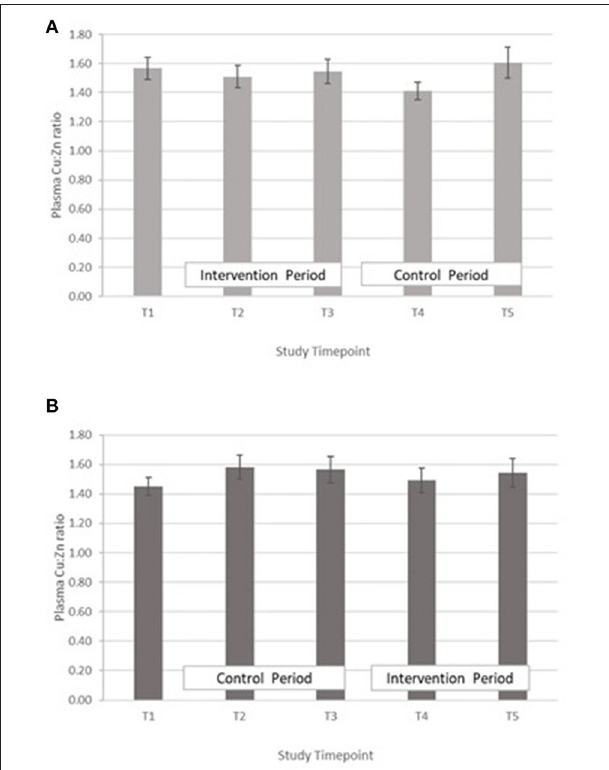
FIGURE 5 | (A) Plasma copper:zinc ratio measured in Group A at baseline (T1), week 4 of period 1 (T2), week 8 of period 1 (T3), week 4 of period 2 (T4) and week 8 of period 2 (T5). Bars indicate estimated marginal means with standard error. (B) Plasma copper:zinc ratio measured in Group B at baseline (T1), week 4 of period 1 (T2), week 8 of period 1 (T3), week 4 of period 2 (T4) and week 8 of period 2 (T5). Bars indicate estimated marginal means with standard error.